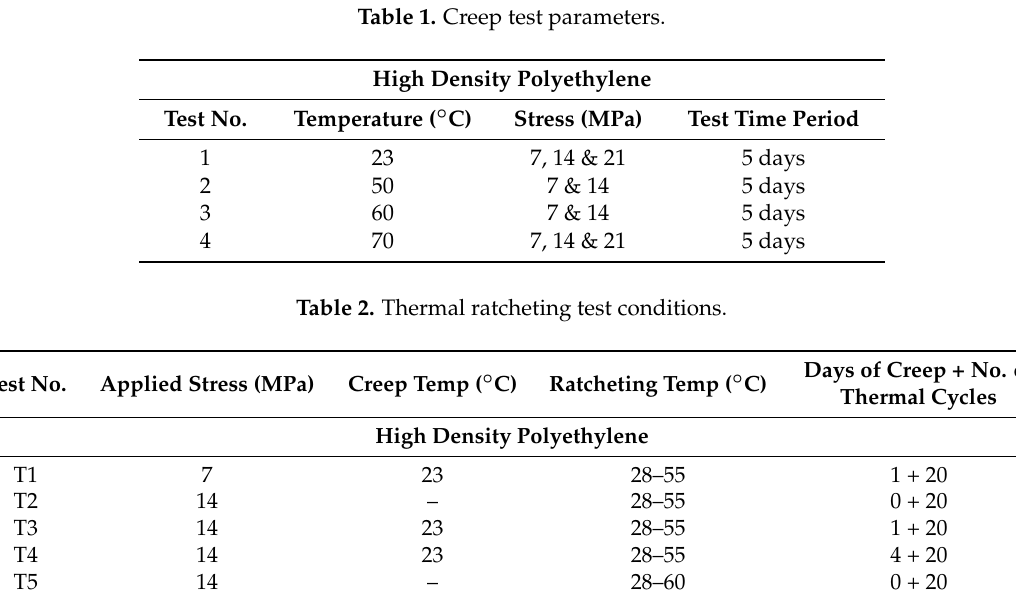
Table 1. Creep test parameters.